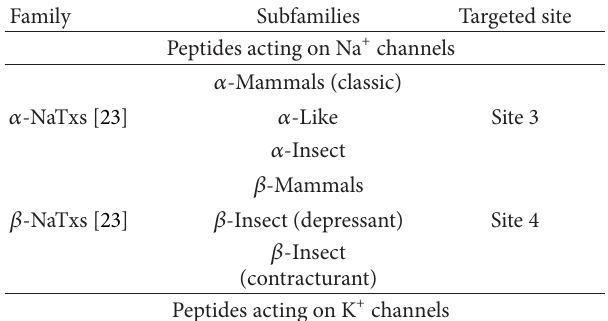
Table 1: List of various families of polypeptides isolated from scorpion venom and